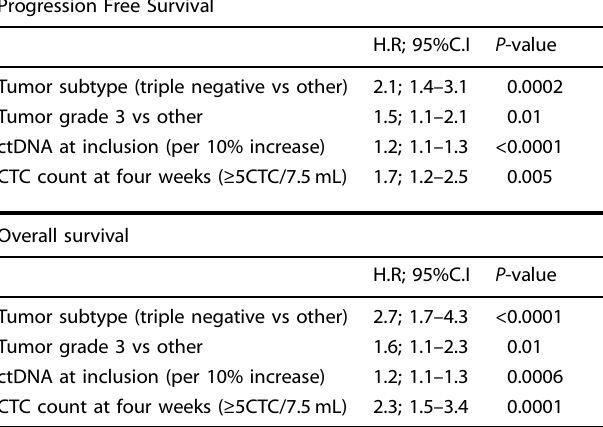
Table 3. Multivariate analysis for PFS and